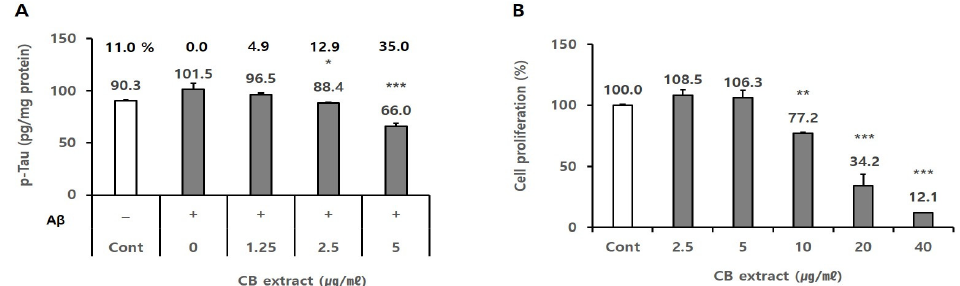
Figure 2. Effect of CB extract on ( A ) p-tau production and ( B ) cell proliferation in A β -treated SH-SY5Y cells. SH-SY5Y cells (1 × 10 5 cells/mL) in 6-well plate were treated with sample extracts (at the final concentrations of 1.25, 2.5, or 5 µ g/mL) for 2 h and with serum free (SF) media as control. The wells were reacted with 0.1 µ M A β 1-42 for 21 h. p-Tau sampling for the ELISA assay was conducted using the manufacturer’s instructions. An MTT assay on the remnant cells that were treated with CB extract (2.5–40 µ g/mL) and not treated with A β 1-42, was conducted at 540 nm. ( − ), A β -untreated experiment; (+), A β -treated experiment; Cont, control. Significance was determined by one-way ANOVA with post hoc Tukey’s multiple comparison test. Data are presented as means ± standard errors of the mean (SEM). * p < 0.05, ** p < 0.01, *** p < 0.001 significance compared with A β -treated cells (black